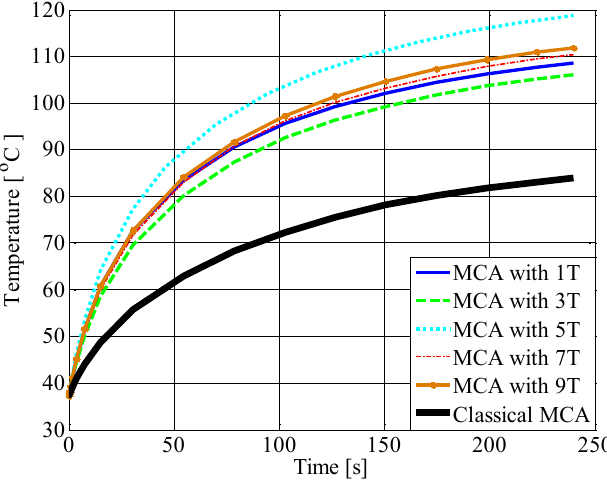
Figure 8: Temperature versus Time for both